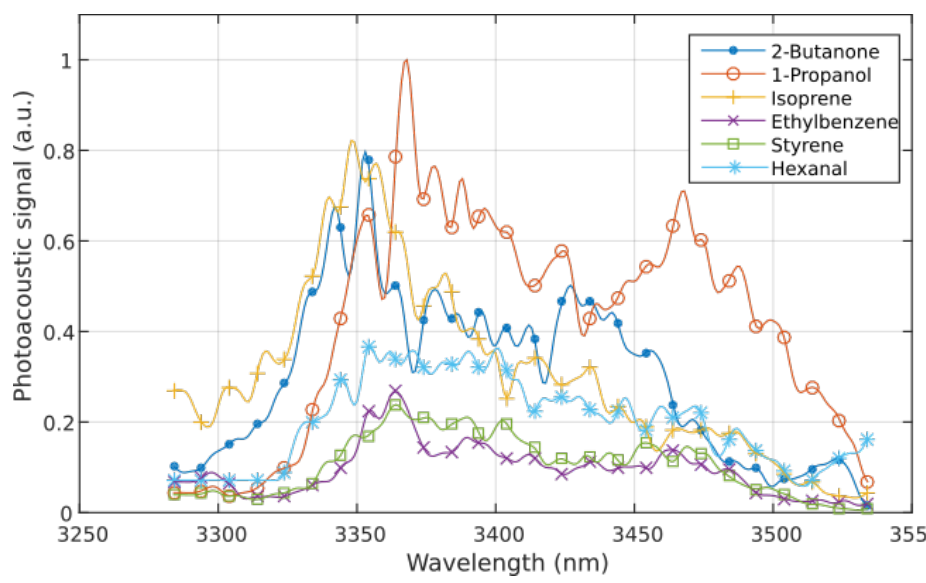
Figure 2. Measured volatile organic compound (VOC) spectra (each 100 ppm in nitrogen).